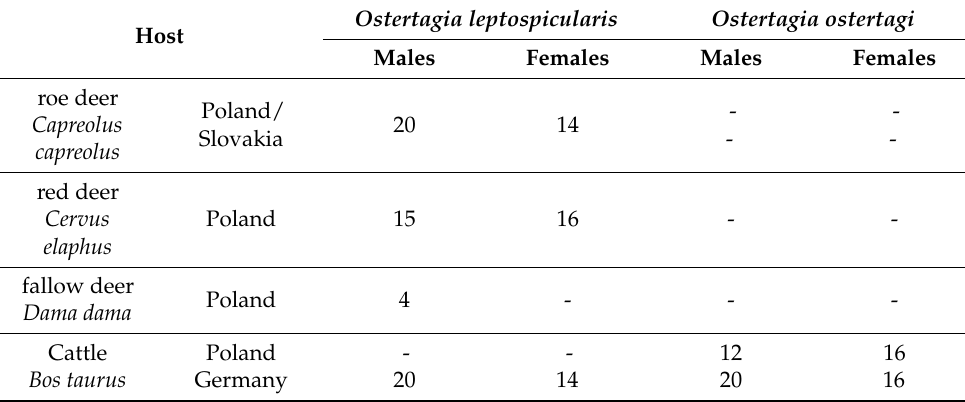
Table 1. Origin of hosts and number of nematode specimens morphometrically